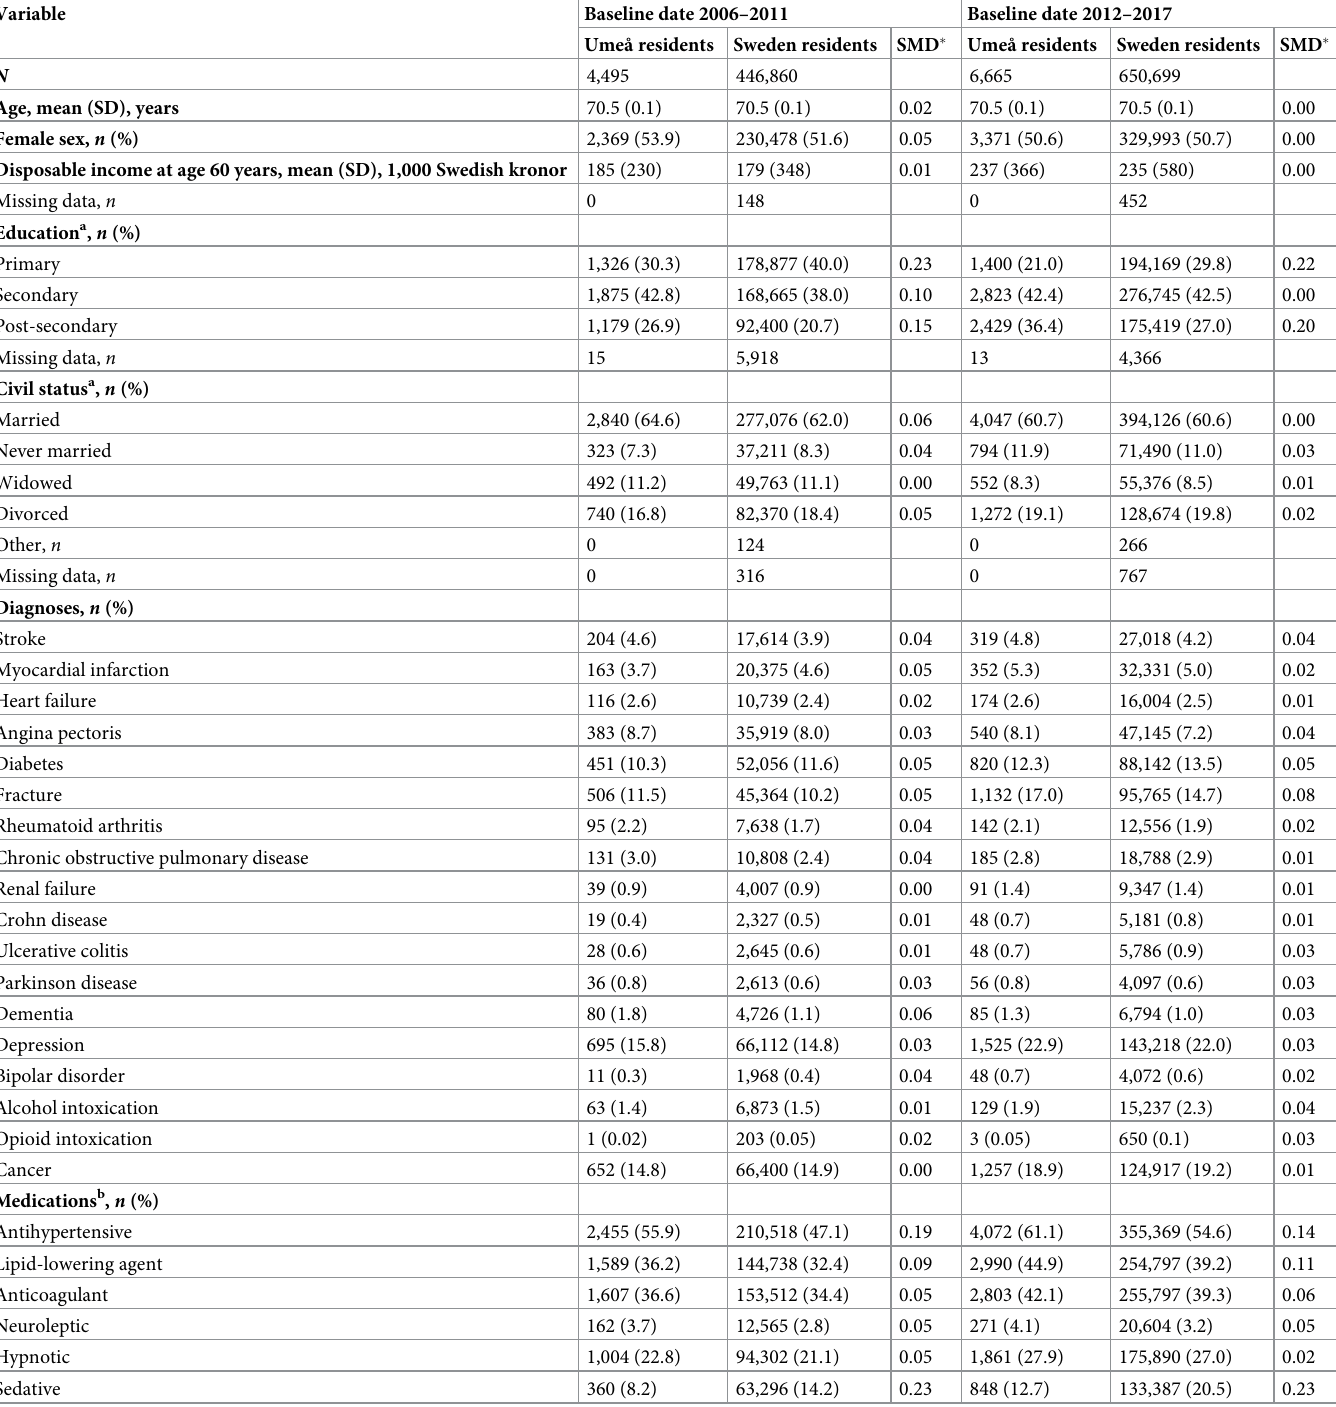
Table 3. Baseline characteristics of 70-year-old Ume å residents and 70-year-old residents from the rest of